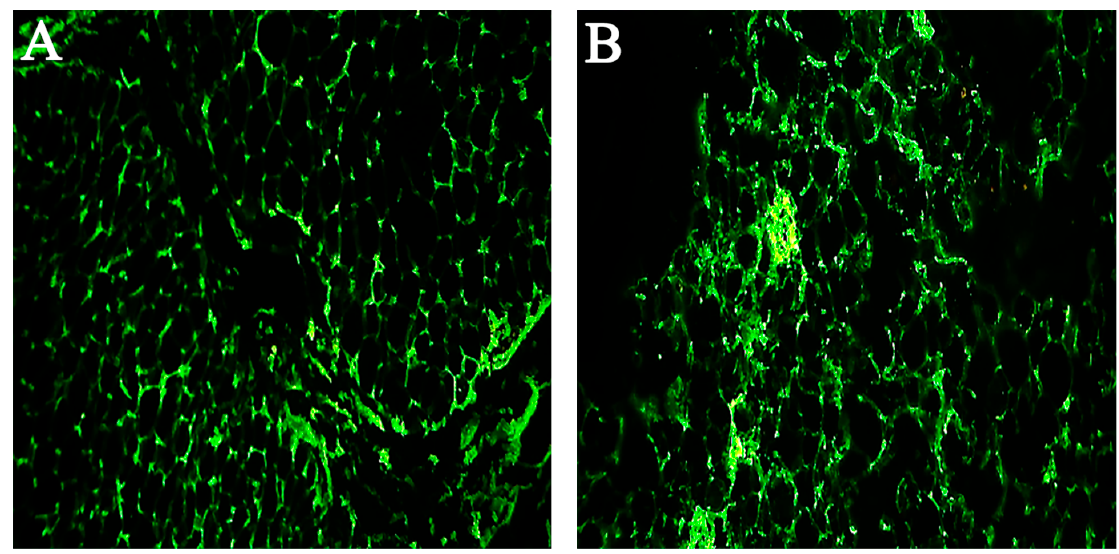
amyloid mass density and the formation of new vessels (Supplementary Figure S4).